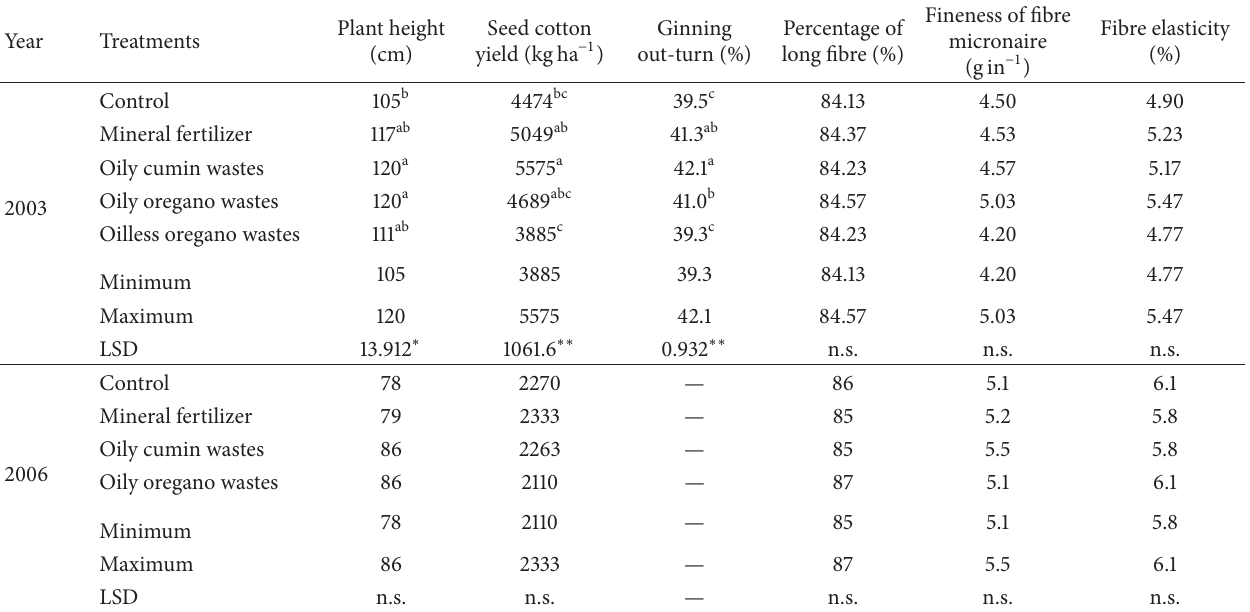
Table 5: Yield and quality parameters of cotton of the experiments from 2003 and